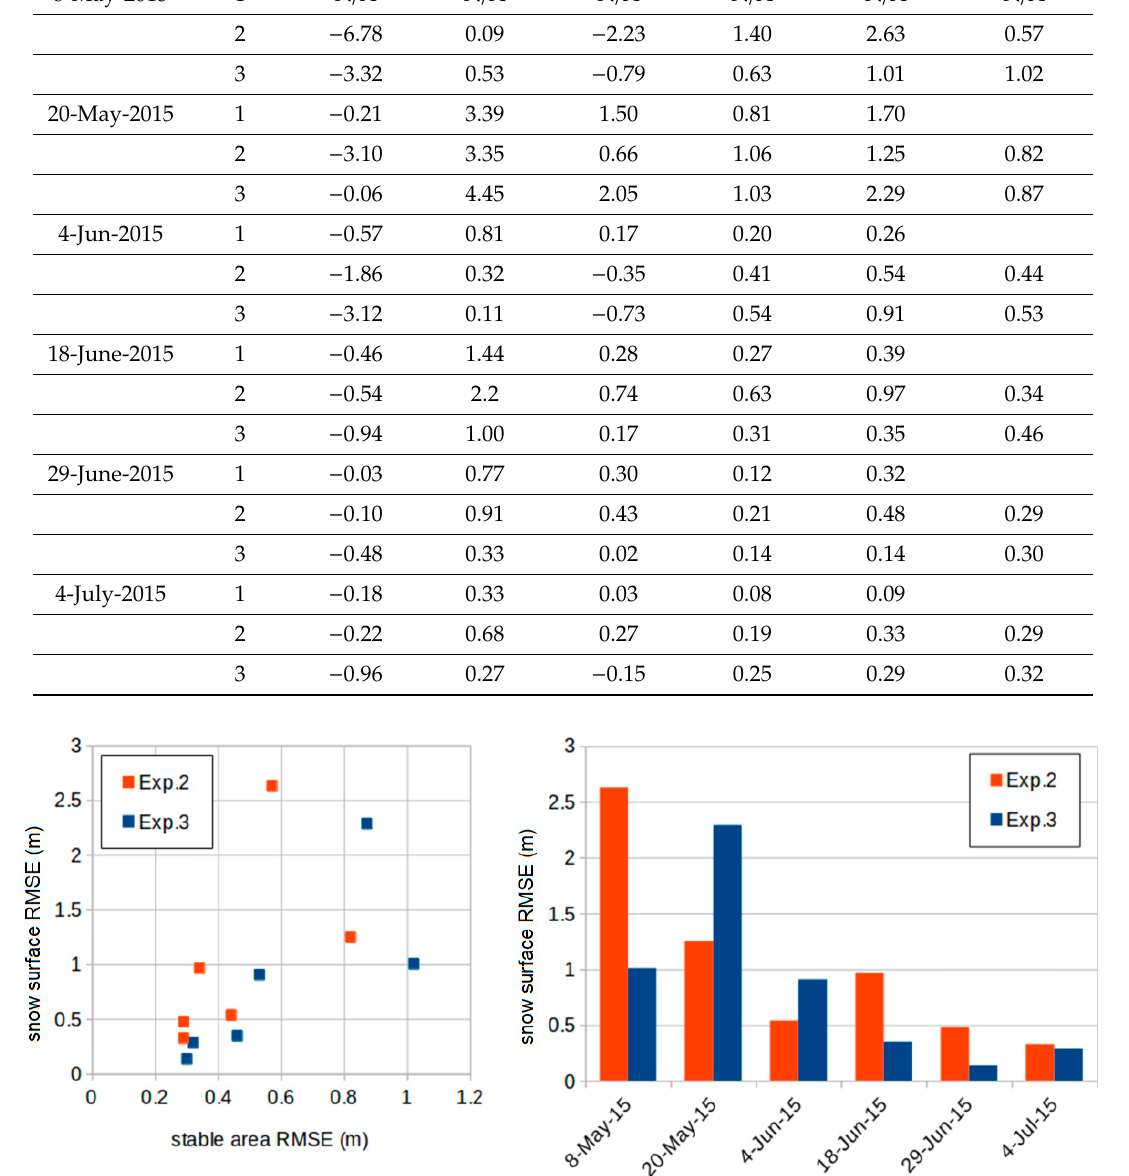
Figure 8. Comparison of the RMSE on the surface elevation from Exp.2 and Exp.3 over the snow surface and the stable area.